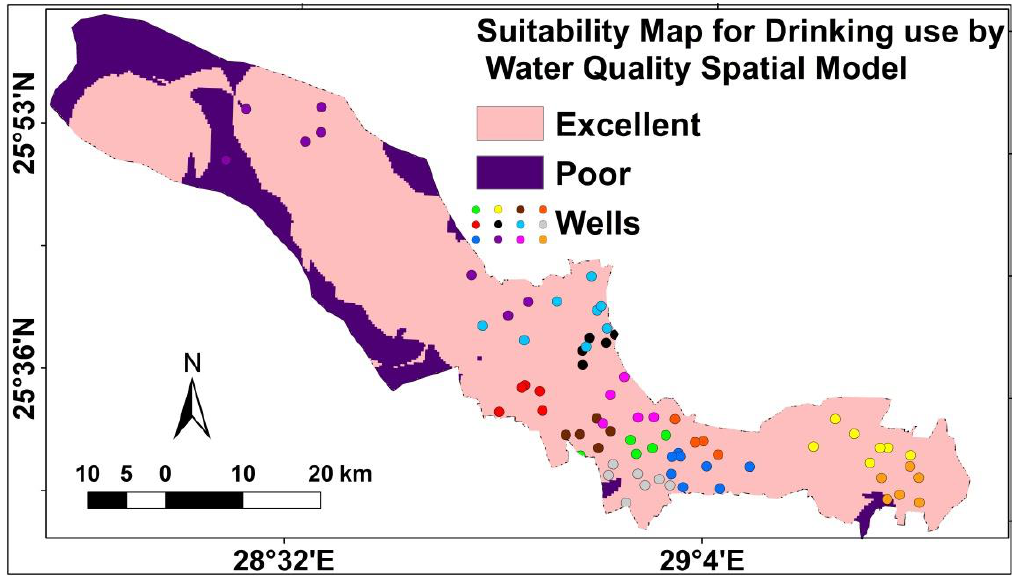
Figure 8. Suitability map for drinking use by a water quality spatial model.